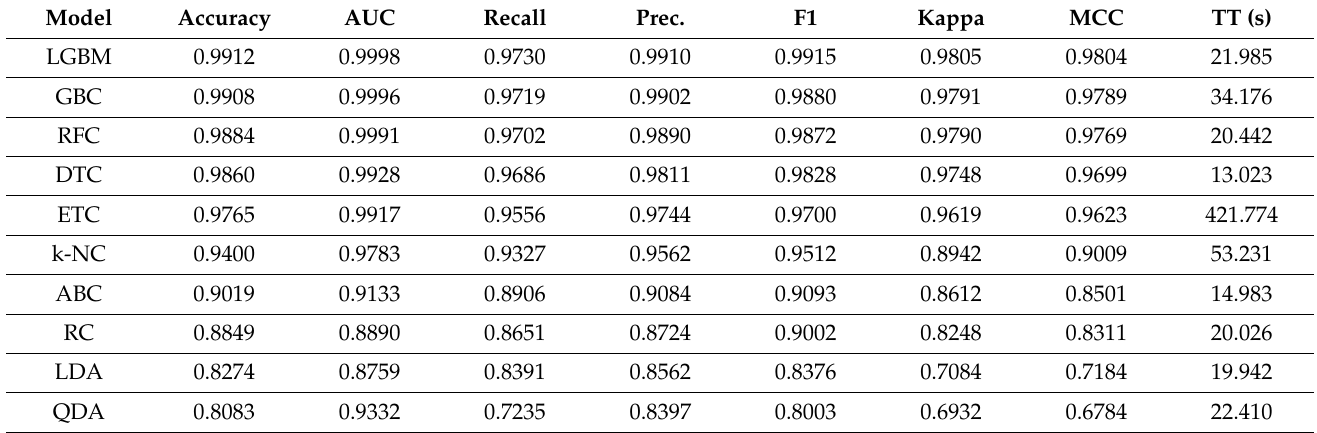
table: Accuracy, Area Under the Curve (AUC), Recall, Precision, F1-score, Cohen’s kappa